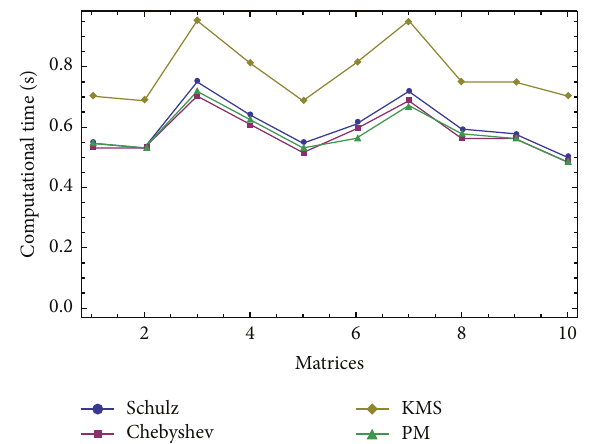
Figure 6: Comparison of the elapsed time for solving Example